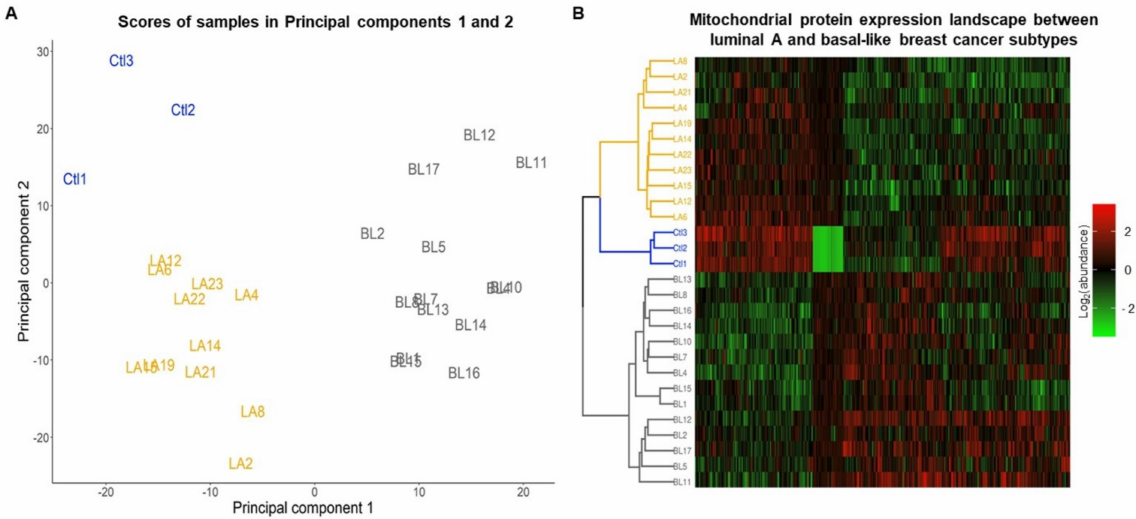
Figure 8. Analysis of the mitochondrial proteome of luminal A and basal-like tumors. ( A ) Principal component analysis of the mitochondrial proteome in samples control (Ctl), luminal A (LA), and basal-like (BL) breast cancer tumors. ( B ) Heatmap and hierarchical cluster analysis of mitochondrial proteins abundance identify in samples control, luminal A, and basal-like tumors of breast